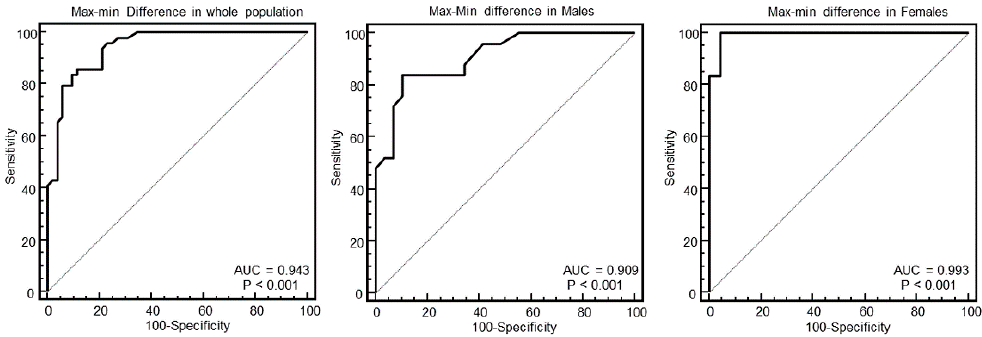
Figure 5. Receiver operating characteristic curves of the difference between maximal and minimal wall thickness (WT) for identification of patients with HCM in the whole population, and in males and females.